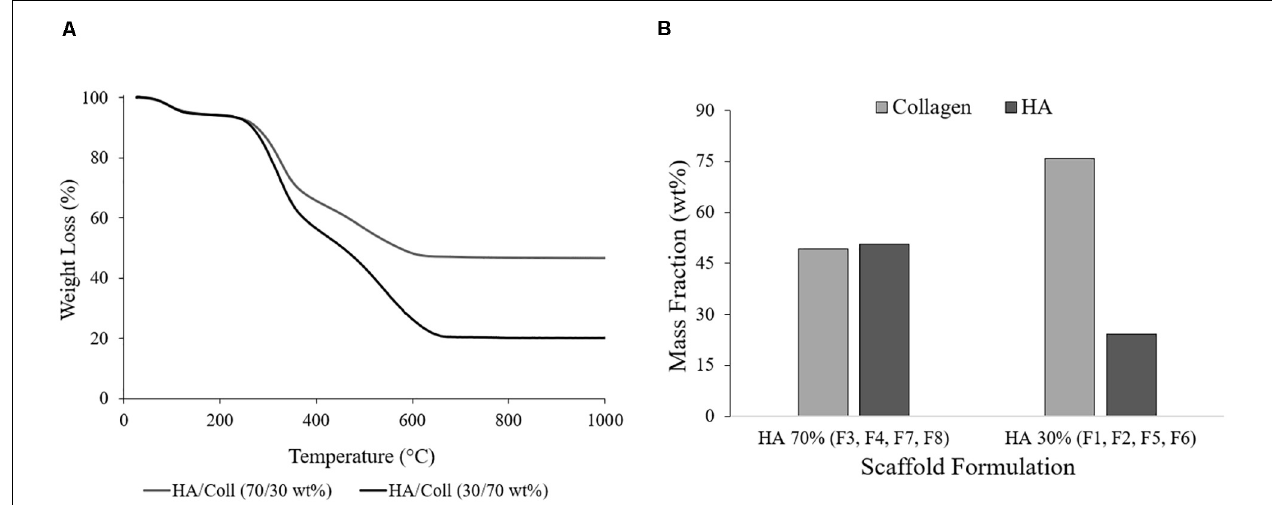
FIGURE 3 | (A) Representative TGA curves of the formulations HA/collagen 70/30 wt. % and 30/70 wt. % (F1 and F7) and (B) average data of the HA and collagen mass fractions (wt.